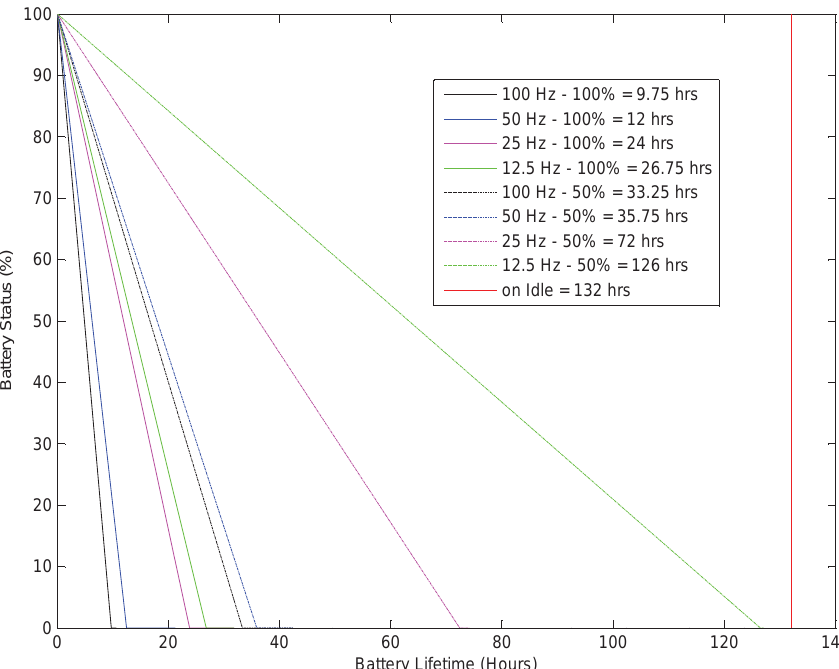
Figure 4. The battery depletion due to variant sampling frequencies and duty cycles within the operation of the accelerometer sensor (samples are taken at every 20